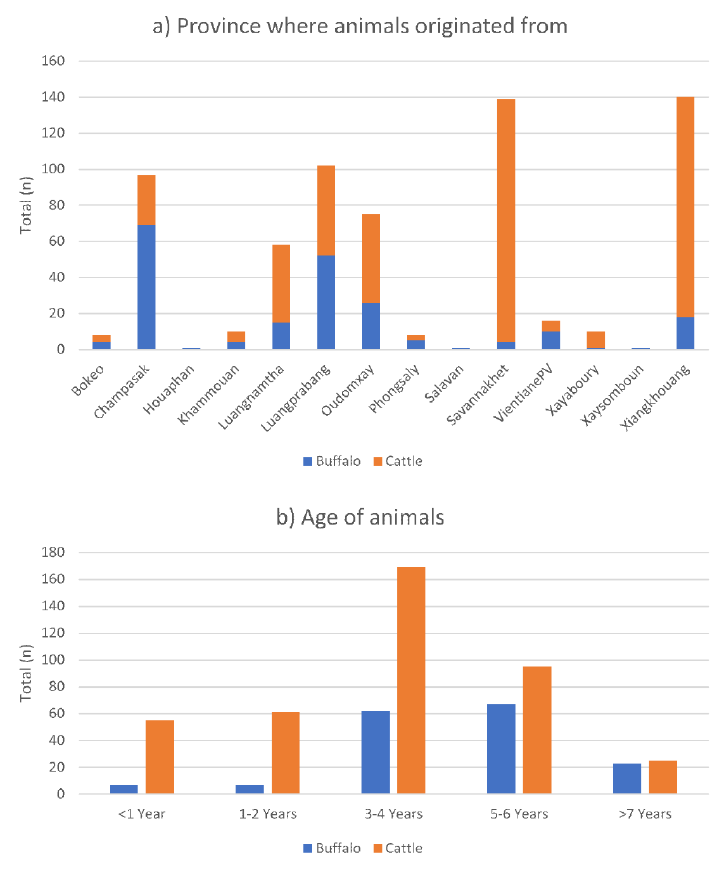
Figure 2. Origin ( a ) and age ( b ) of the animals. Table 1 . Q Fever and brucellosis Ab ELISA results .